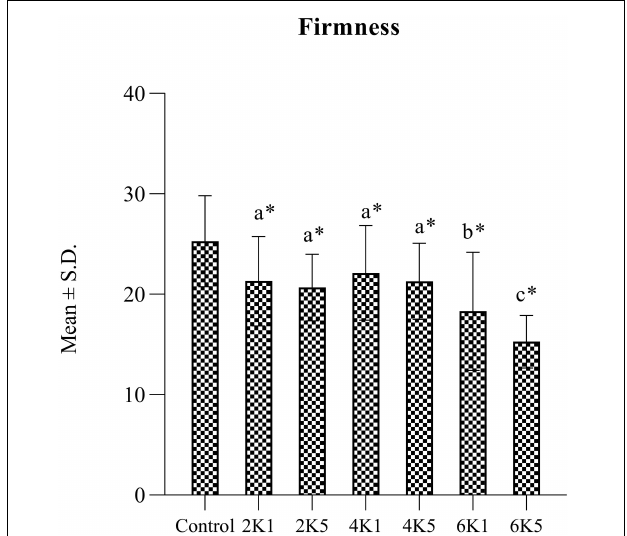
FIGURE 2 | Firmness (N) of control and HPP chickpea samples (2K1 = 200 MPa, 1 min; 2K5 = 200 MPa, 5 min; 4K1 = 400 MPa, 1 min; 4K5 = 400 MPa, 5 min; 6k1 = 600 MPa, 1 min; and 6K5 = 600 MPa, 5 min). Bars bearing different letter are significantly ( p < 0.05) different to each other. Bars bearing * are significantly ( p < 0.05) different to the